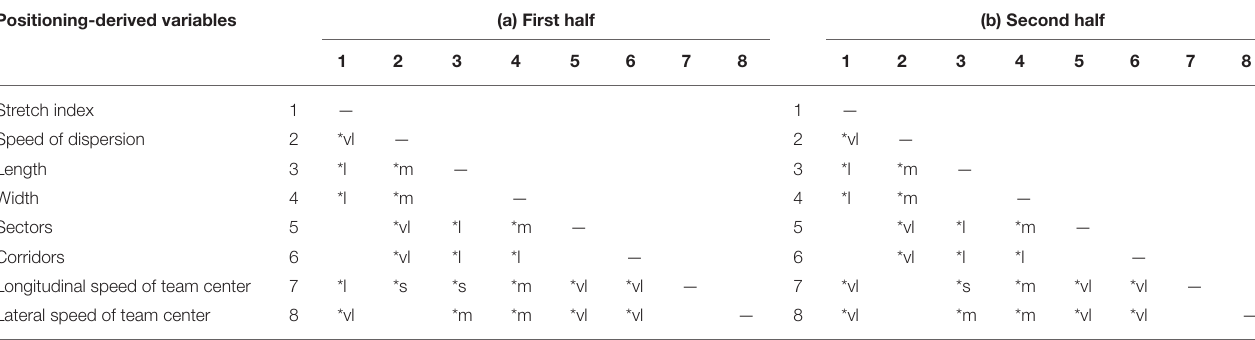
TABLE 3 | Multiple Comparisons p -values (2-tailed) and Cohen’s d results for (a) the first half and (b) the second half. Positioning-derived variables